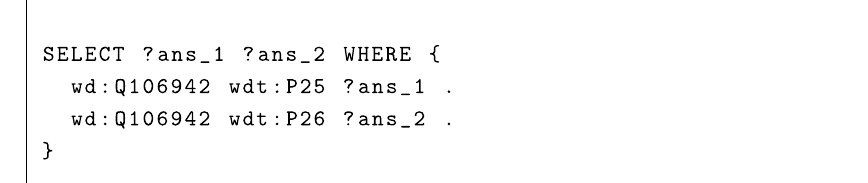
Fig. 2 Ground truth SPARQL query for the question “Who is the mother and husband of Candice Bergen?” from the LC-QuAD 2.0